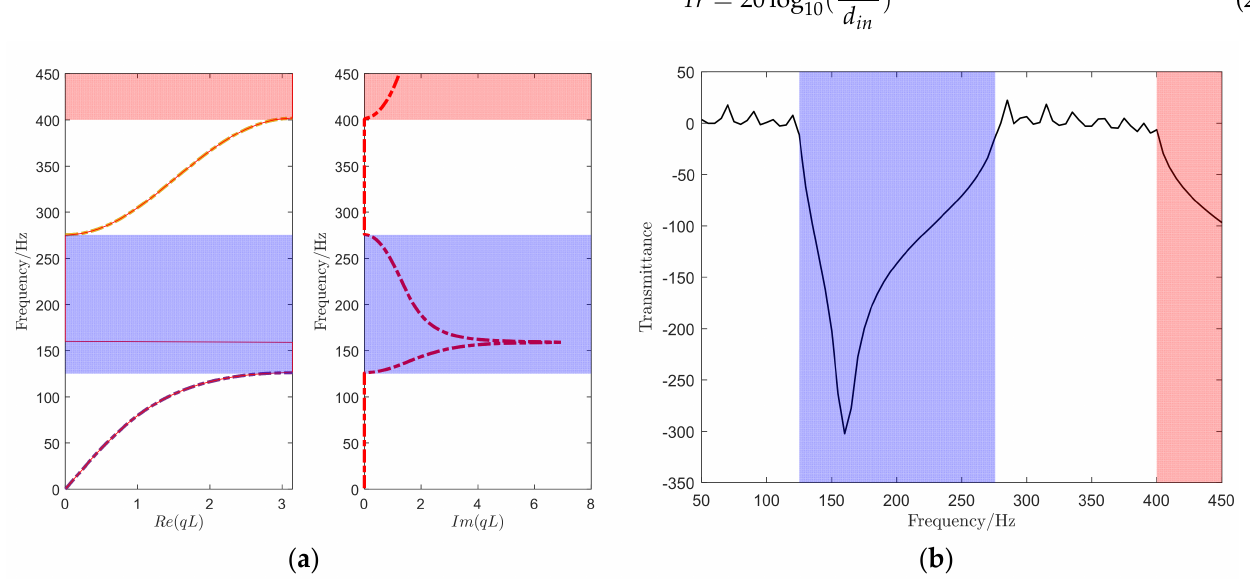
Figure 7. ( a ) Analytical solution of the dispersion relation for an infinite lattice chain. ( b ) Transmittance of a finite lattice chain calculated with the FEM